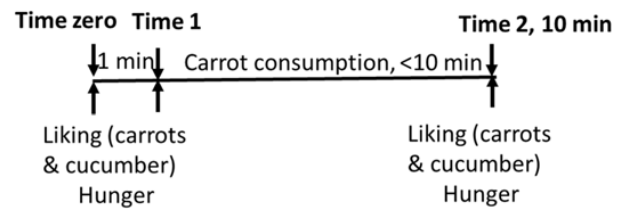
Figure 1. Schematic overview of the experimental session.